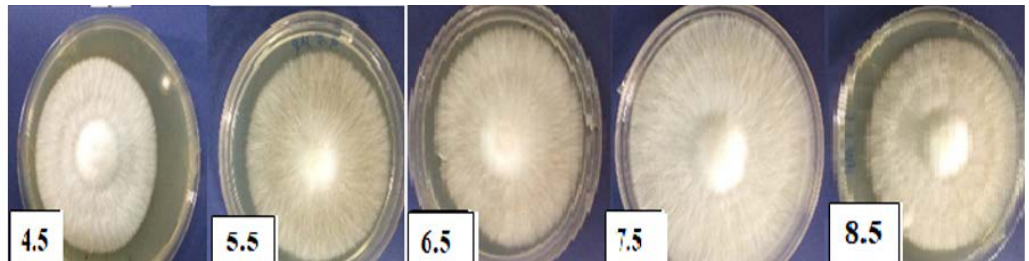
Fig. 5A. Effect of different pH levels (4.5, 5.5, 6.5, 7.5, and 8.5 on colony growth of M. palmivorus after 4 days of incubation)